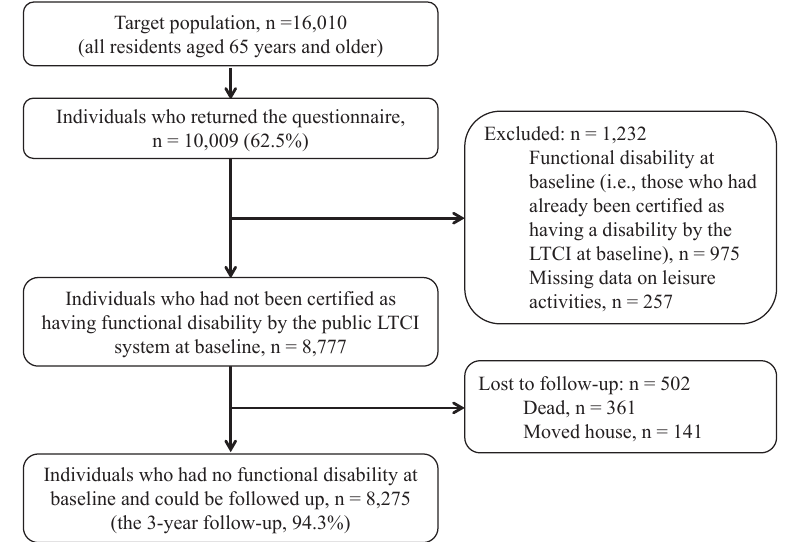
Fig. 1 Flow chart of study participants. LTCI, Long-term Care